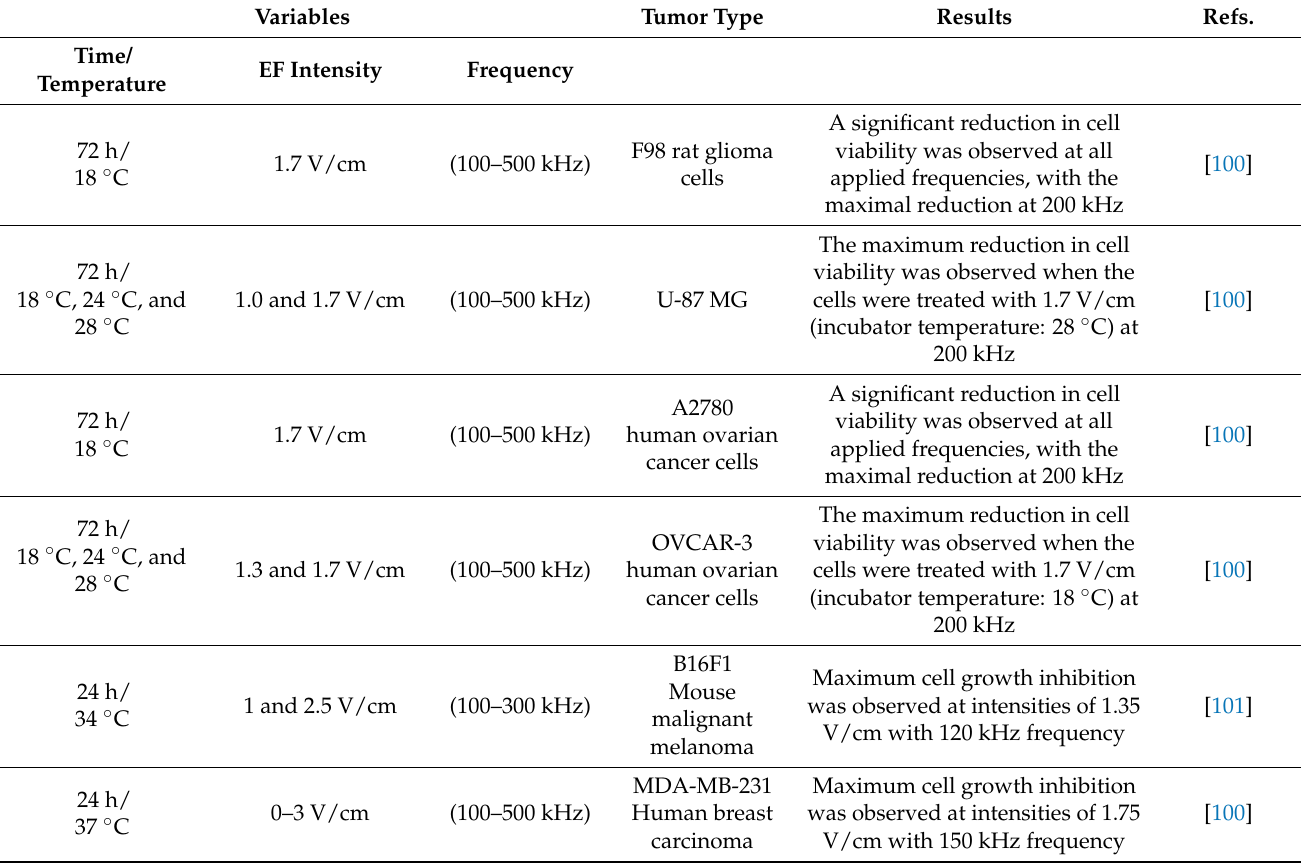
Table 3. Tumor-treating fields (TTFields) parameters used to treat different cancer cells. Tumor Type Results